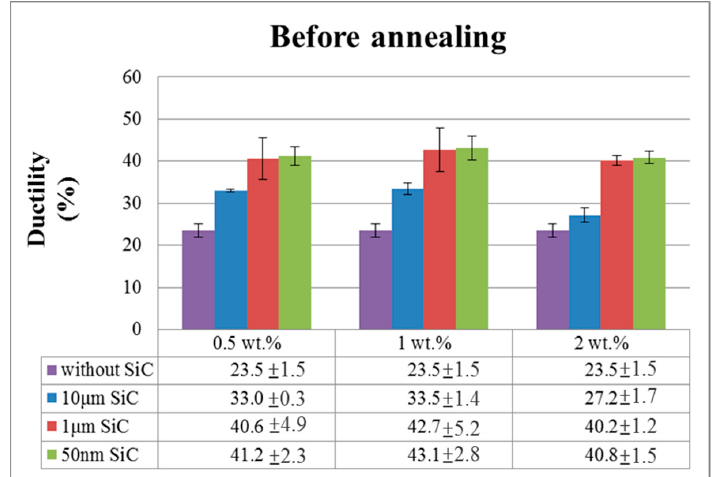
Figure 4. Ductility of the AZ61/SiCp MMC extruded plates before annealing.